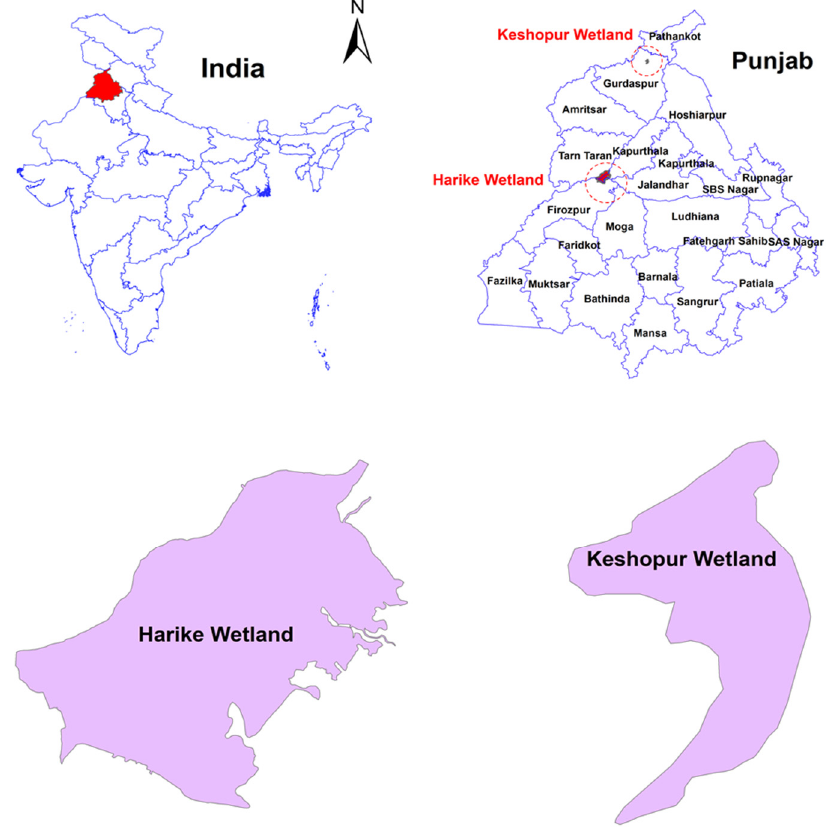
Figure 1. Locations of study where sentionel-2 MSI data acquired during pre- and post-monsoon season.